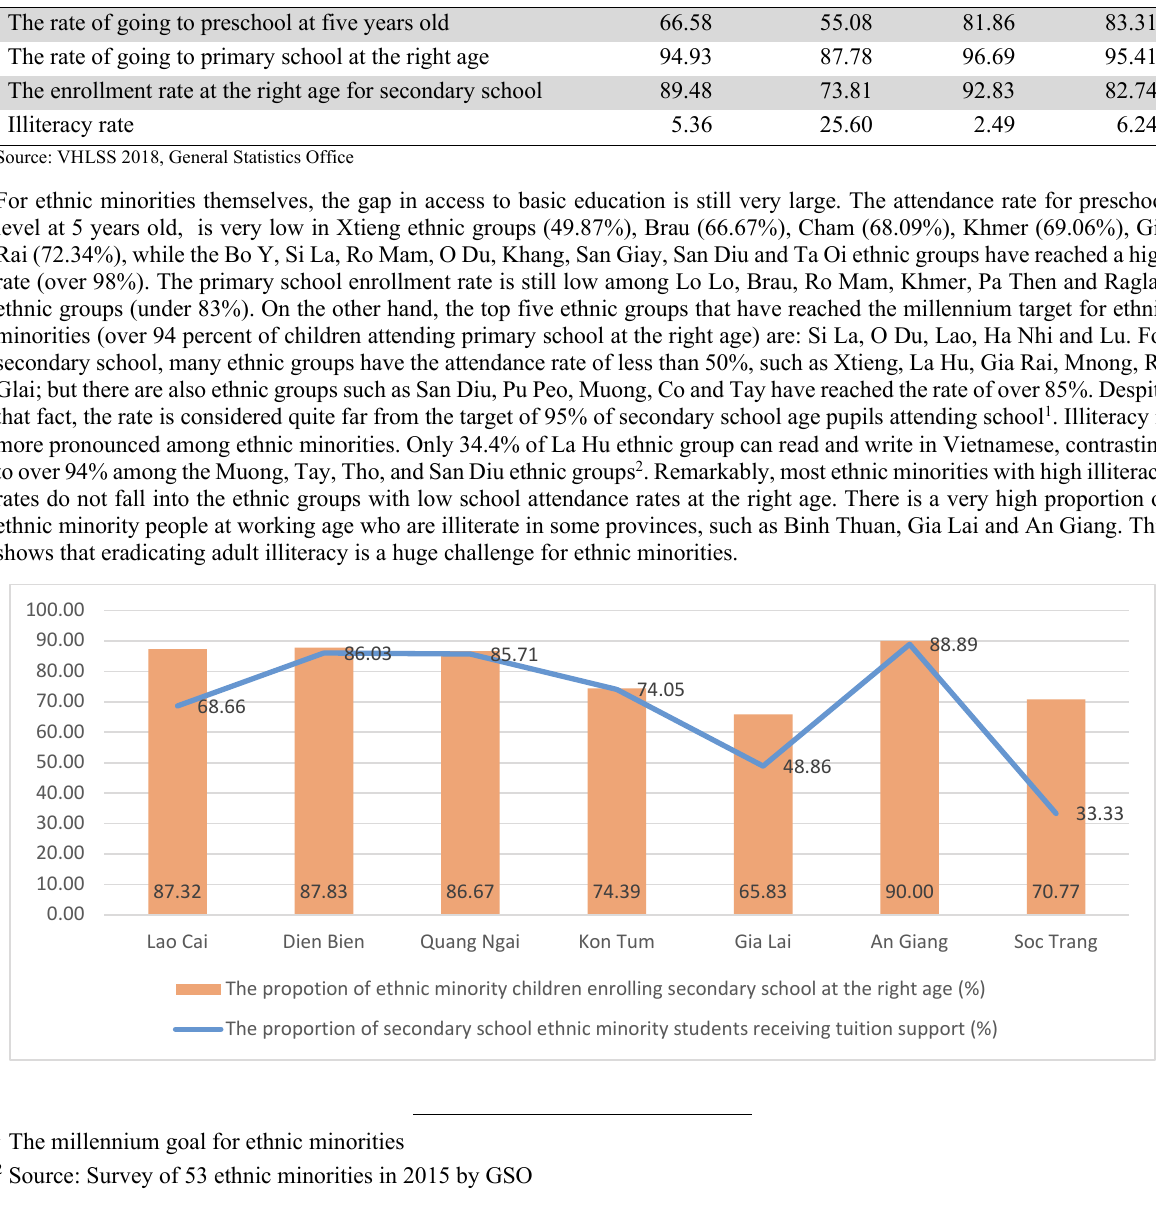
Proportion of people accessing basic education, 2008 - 2018,% Items Kinh Ethnic minor-